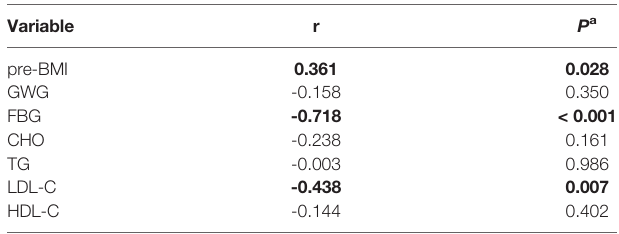
TABLE 2 | Linear correlation analysis between the clinical indicators and circulating FGF21 at